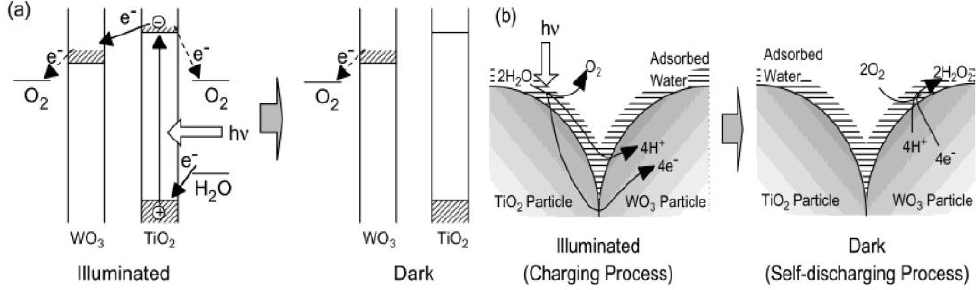
Figure 1. (a) Mechanism of reductive energy storage of TiO (b) Proposed models of electron and ion transfer in the charging and self-discharging processes of the TiO /WO composite film in humid air 2 3